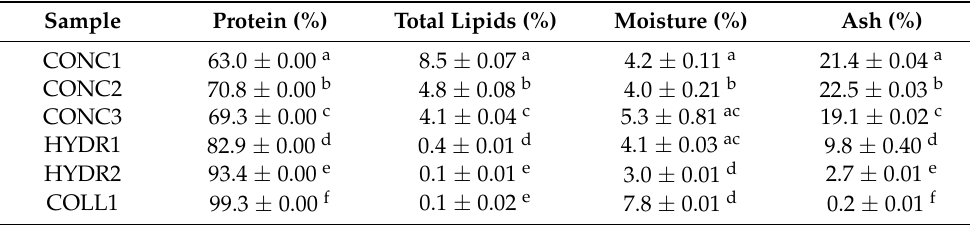
Table 2. Proximate composition of the commercial fish protein concentrates, hydrolysates, and hydrolyzed collagen with mean and standard deviation of three replicate measurements. Different letters within the same row indicate a statistically significant difference with ANOVA post hoc pair comparison ( p <